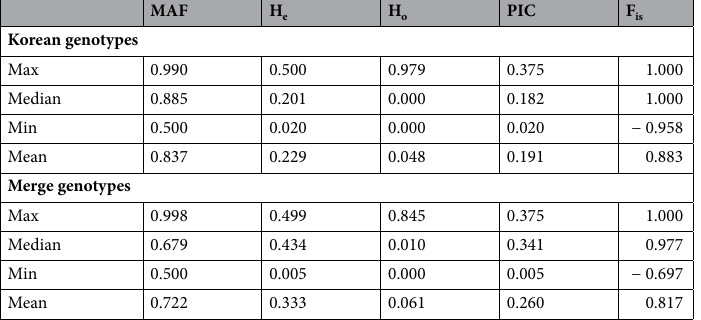
Table 1. Summary of genetic diversity statistics of Korean set data (96 genotypes) and Merge set data (207 genotypes) of peanuts (MAF, major allele frequency; He, expected heterozygosity; Ho, observed heterozygosity; PIC, polymorphism information content; F is , F-statistics, inbreeding coefficient of an individual relative to